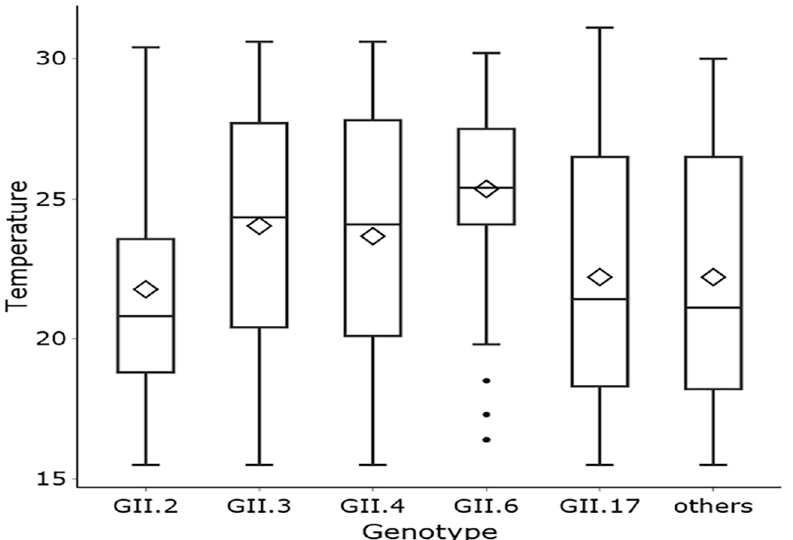
Figure 3. Relationship between norovirus GII genotypes and temperature; p < 0.0001 as calculated using the Kruskal–Wallis test. Table 3. Relationship between norovirus genogroup II genotypes and temperature in Taiwan, 2015– 2019.